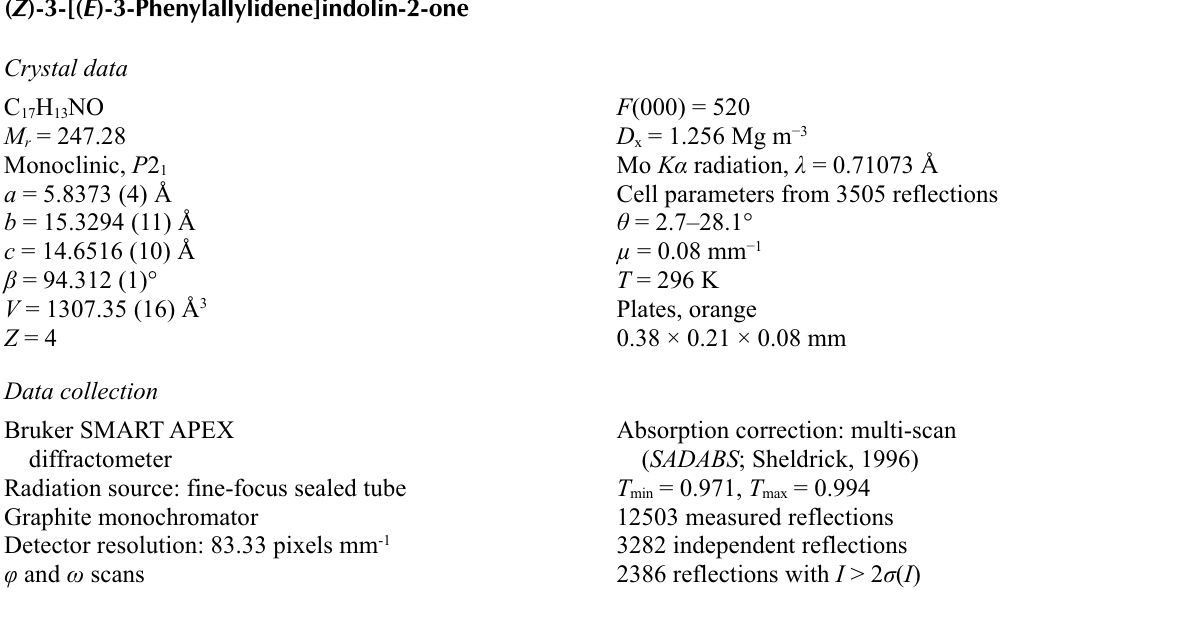
A unit cell packing view of the title compound. Dash lines indicate hydrogen